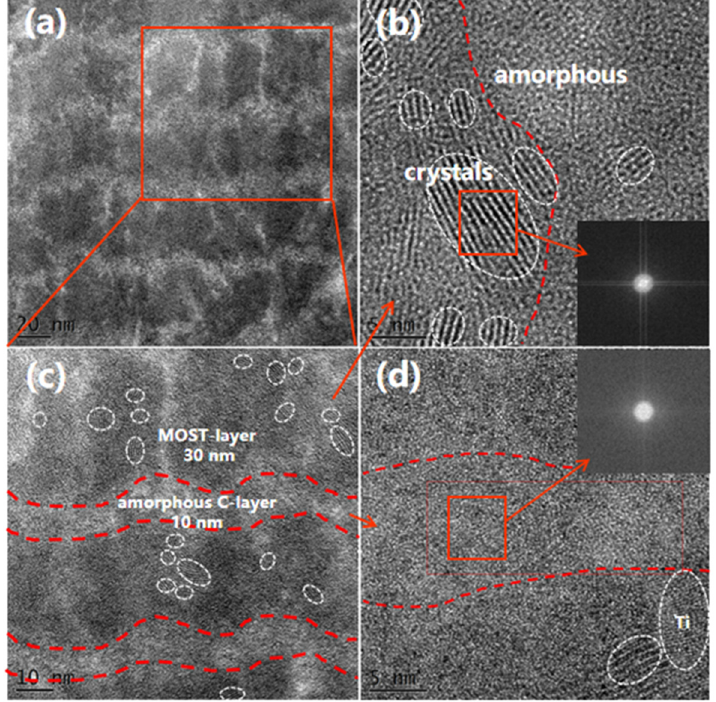
Figure 3. Cross-section TEM image and local magnification image of the pristine film. ( a ) cross- section; ( b ) MOST-layer; ( c ) (a)-local magnification; ( d ) C-layer.